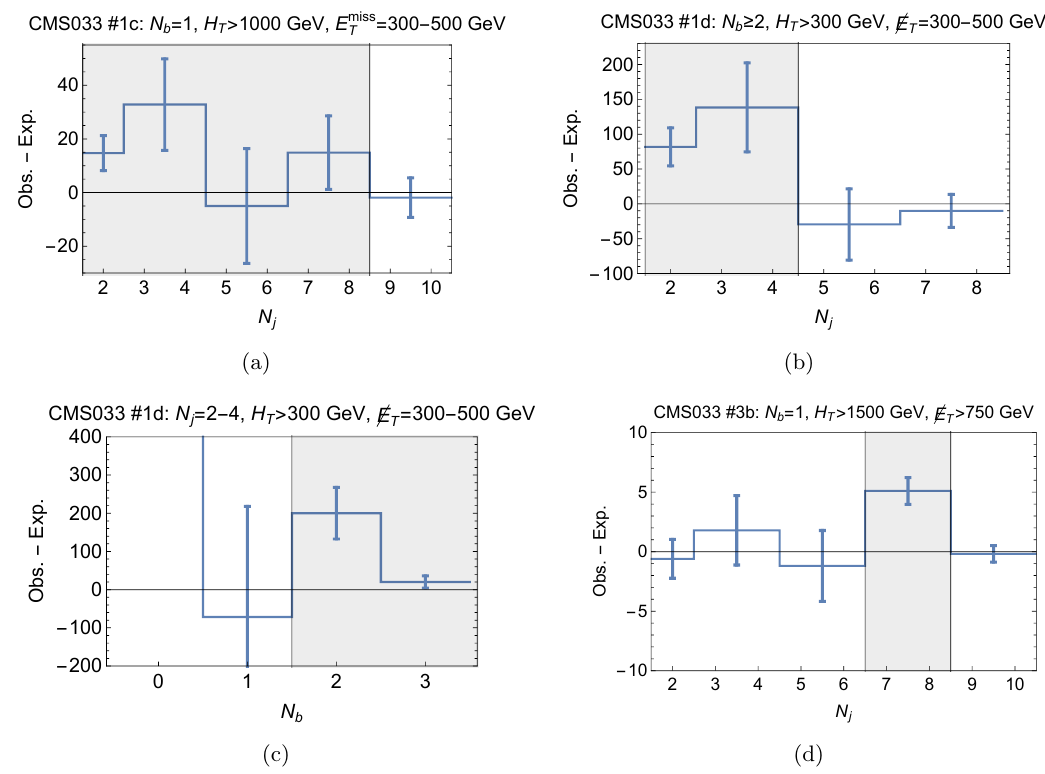
Figure 14 . Kinematic distributions which suggest various CMS033 excesses (see table 2) are unlikely to be new physics. The residuals (observed minus expected) are shown in blue, (with error bars denoting the error). In each plot, the shaded grey region denotes the region with an observed excess. See text for